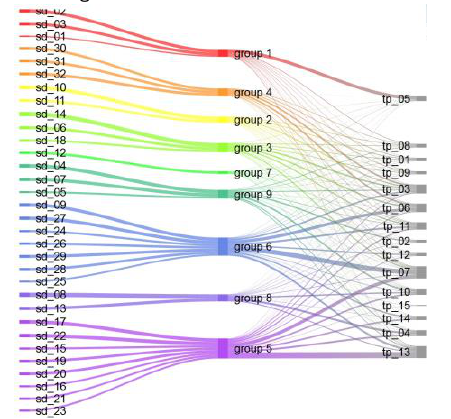
Figure 7. The aggregation process of 32 demographic groups and the relationship between demographic groups and travel patterns. The left denotes the original 32 social-demographic groups, the middle is the 9 groups aggregated by the passenger distribution across travel patterns, and the right are the 15 travel patterns. Figure 9. The passenger distribution of group 4 and 6 across 15 distinct travel